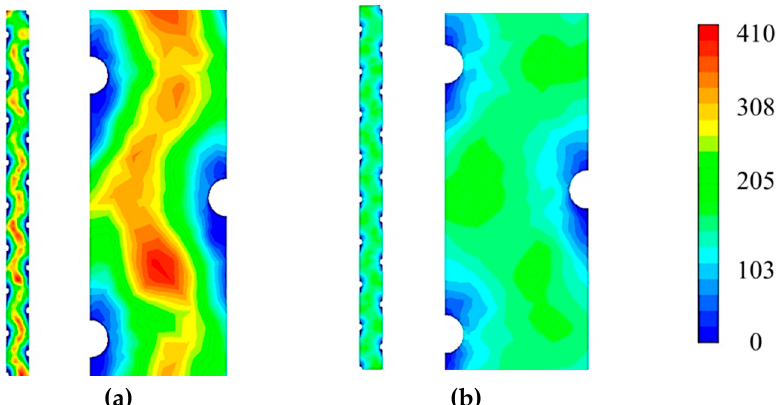
Figure 9. Reynolds number contours of PF channel geometry simulated at the membrane surface total chamber contour of average Reynolds Number at a CFV of 0.575m / s for ( a ) 0% and ( b ) 70% occlusion.